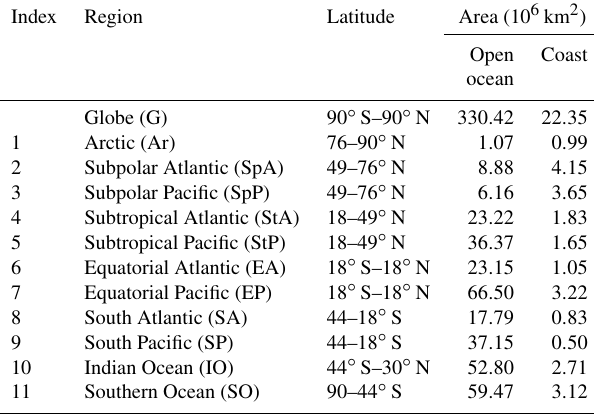
Table 1. Indication of 11 RECCAP1 regions (Fig. 2). Only the total area with respect to the maximum coverage of the reconstructed data is accounted for in each